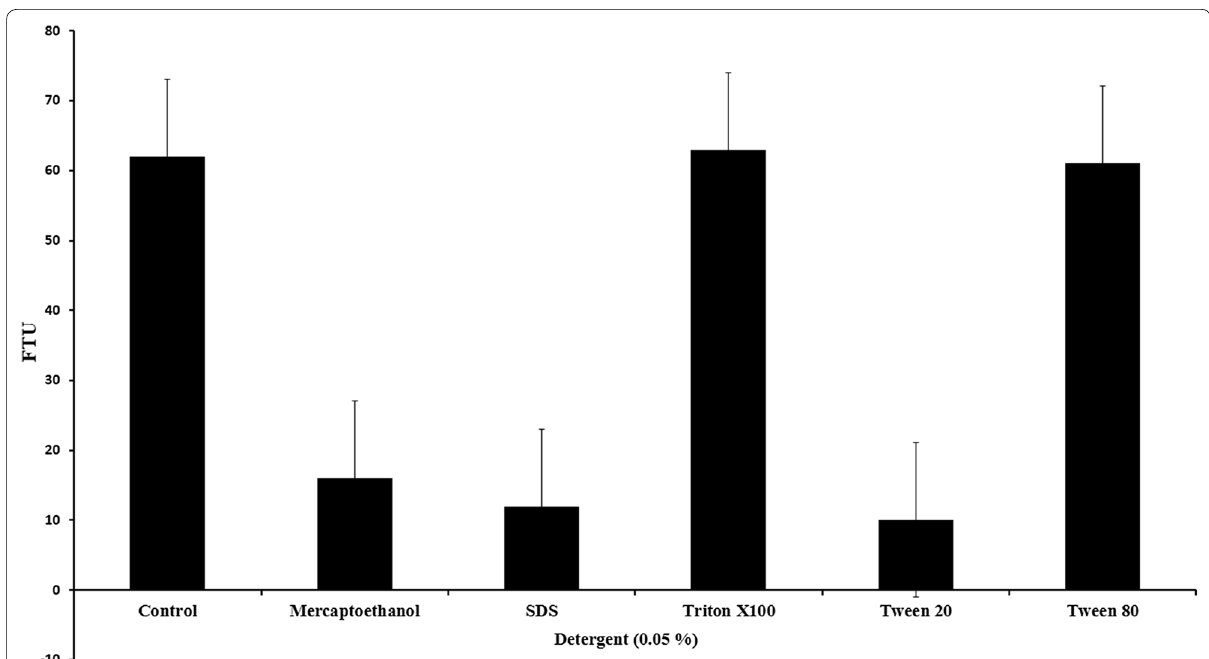
Fig. 4 Effect of detergents on purified phytase from Aspergillus foetidus MTCC 11682. No detergents exhibited an inducing effect on the phytase activity however, mercaptoethanol, SDS and Tween 20 showed an inhibitory